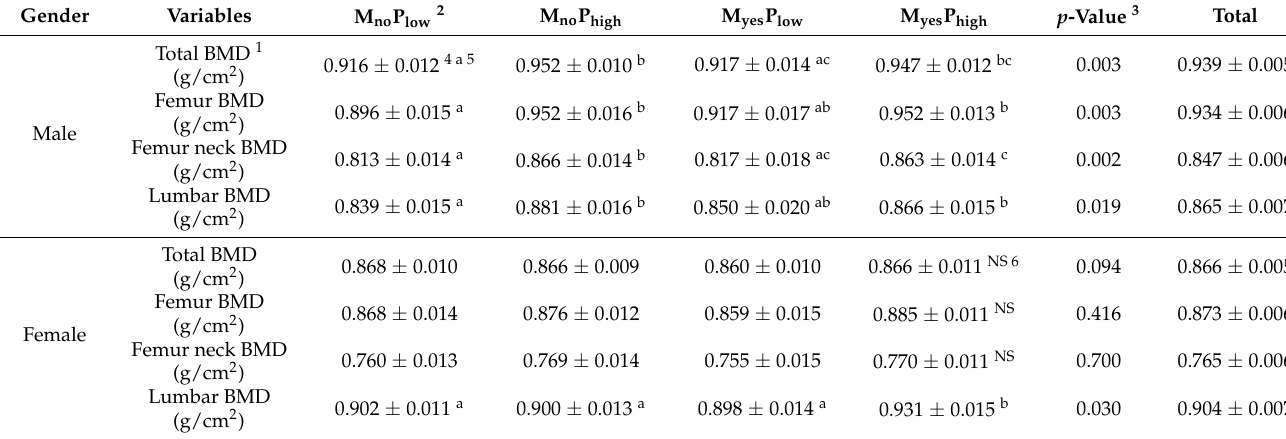
Table 5. Bone mineral density among the groups of the combination of milk intake and physical activity.